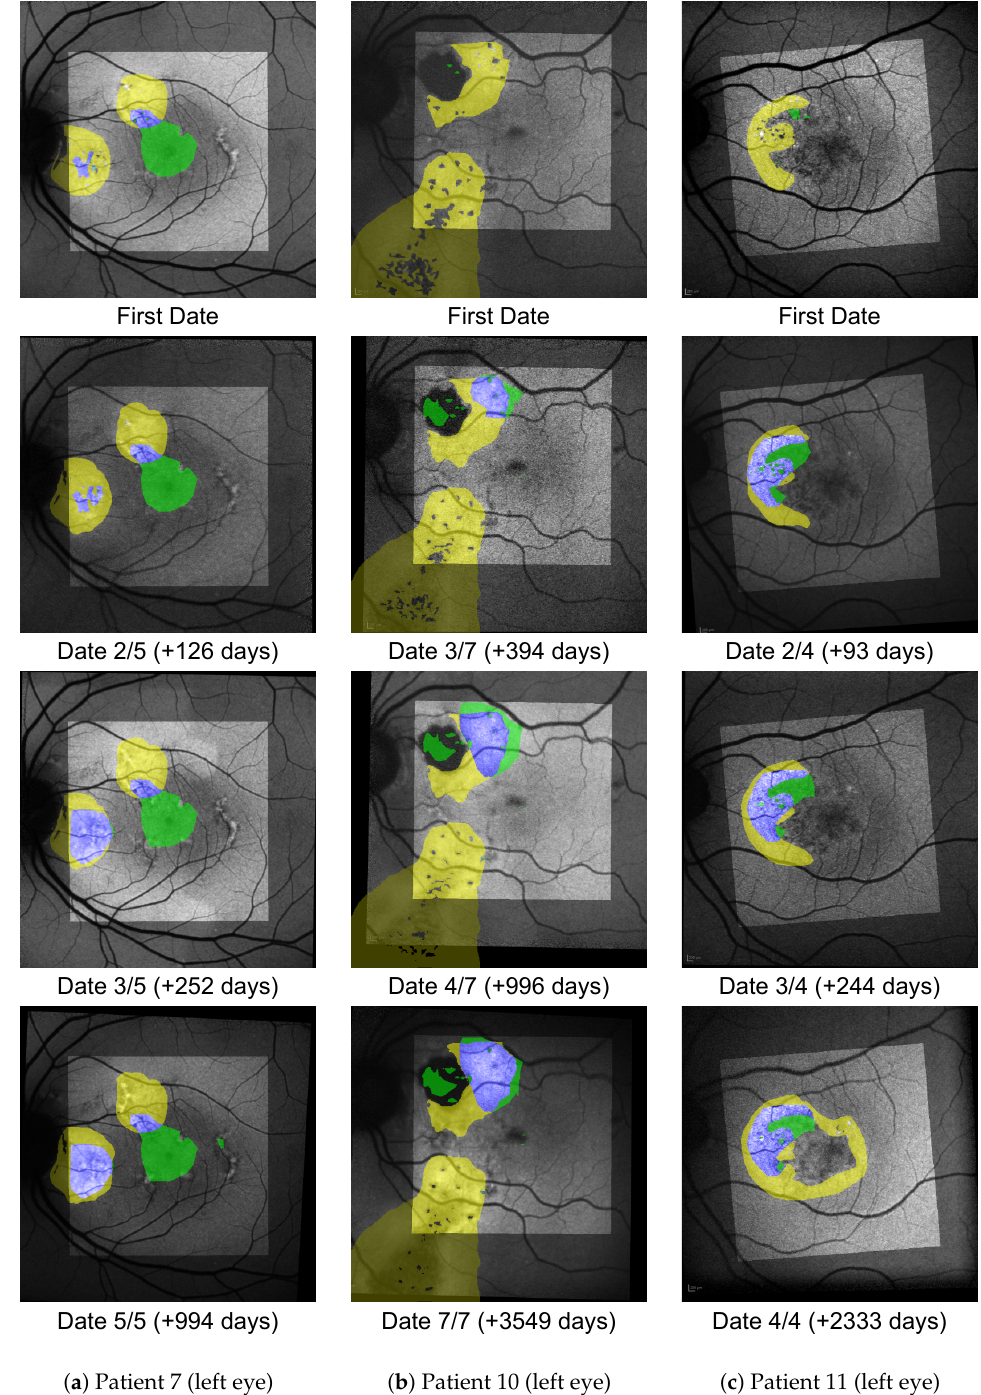
Figure A2. Shown here are progressions from pattern B, where HF precedes